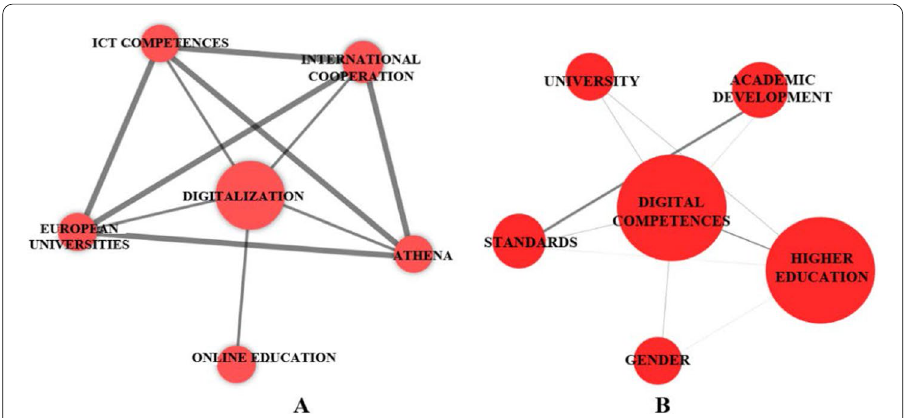
Fig. 6 Thematic networks showing A highly more relevant topics and B cross‑cutting